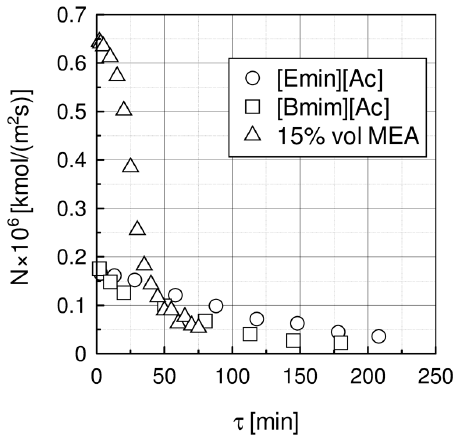
Figure 3. Comparison of molar fluxes of absorbed CO 2 for investigated liquids at 1 bar, tempera- ture 40 °C, Cin = 15% vol. and gas flow rate V g = 138 L/h. In Figure 3, the measured CO 2 molar fluxes are compared. The initial CO 2 molar flux for 15% wt. MEA solution is significantly higher and decreases faster with time than for ILs. Experimental results show that imidazolium-based ionic liquids can be applied in a packed column for CO 2 removal from post-combustion gases. In Table 1, physical parameters of the CO 2 absorption in a packed column are pre- sented for: temperature 40 °C, co-current flow, inlet CO 2 concentration 15% vol. Table 1. The physical parameters of the CO 2 absorption process in a packed